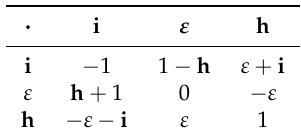
Table 1. The hybrid number